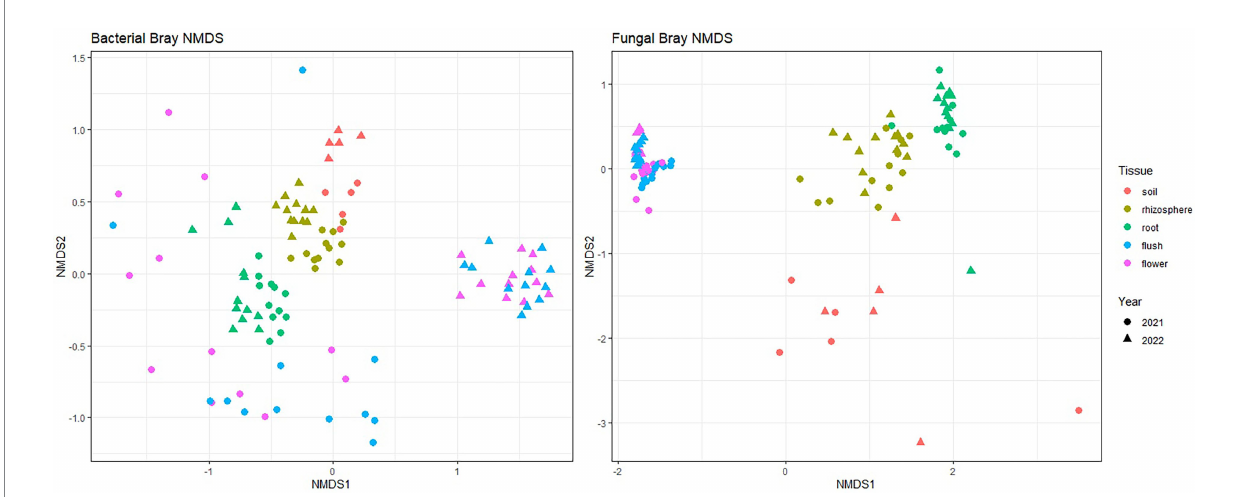
FIGURE 2 Bray–Curtis beta diversity for bacteria (left panel) and fungi (right panel) across five different citrus biocompartments (soil, rhizosphere, root, flush and flower). Points represent individual sample communities for one biocompartment from one citrus tree at 1 year. Points are colored by biocompartment and shaped by year